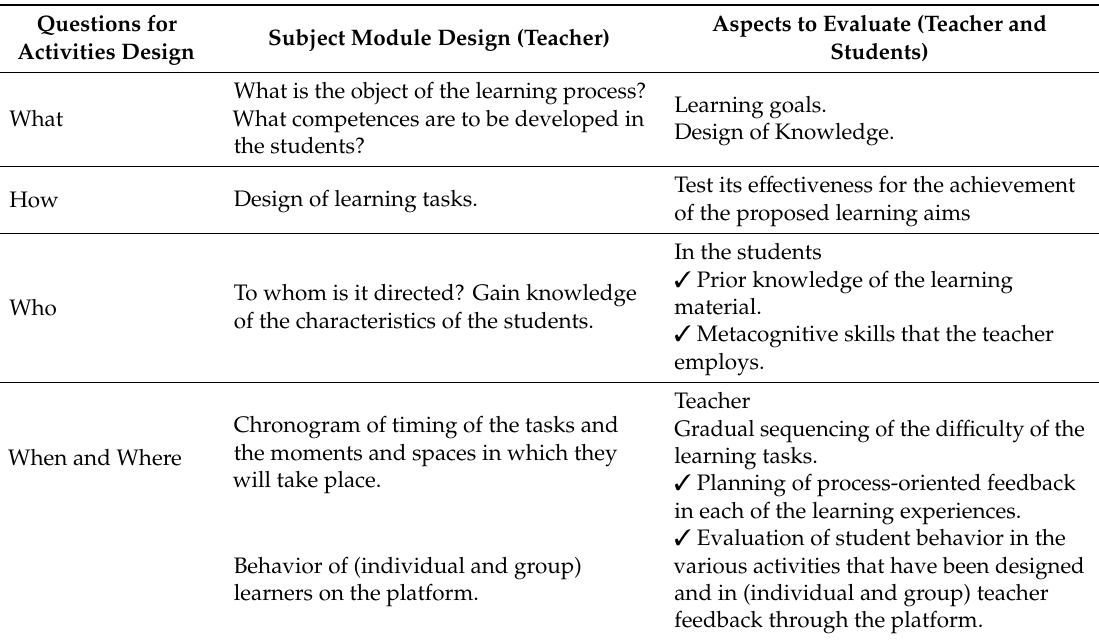
Table 1. Preliminary elements to take into account for the design of learning